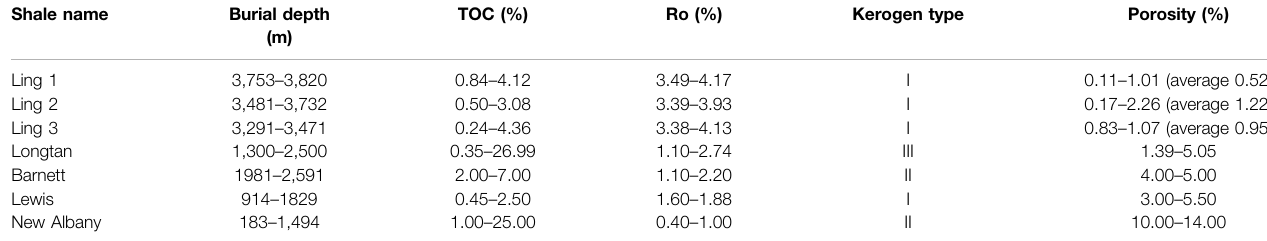
TABLE 1 | Key parameters of major gas shale in America and the Linghao Formation shale (modi fi ed from Luo et al., 2018). Shale name